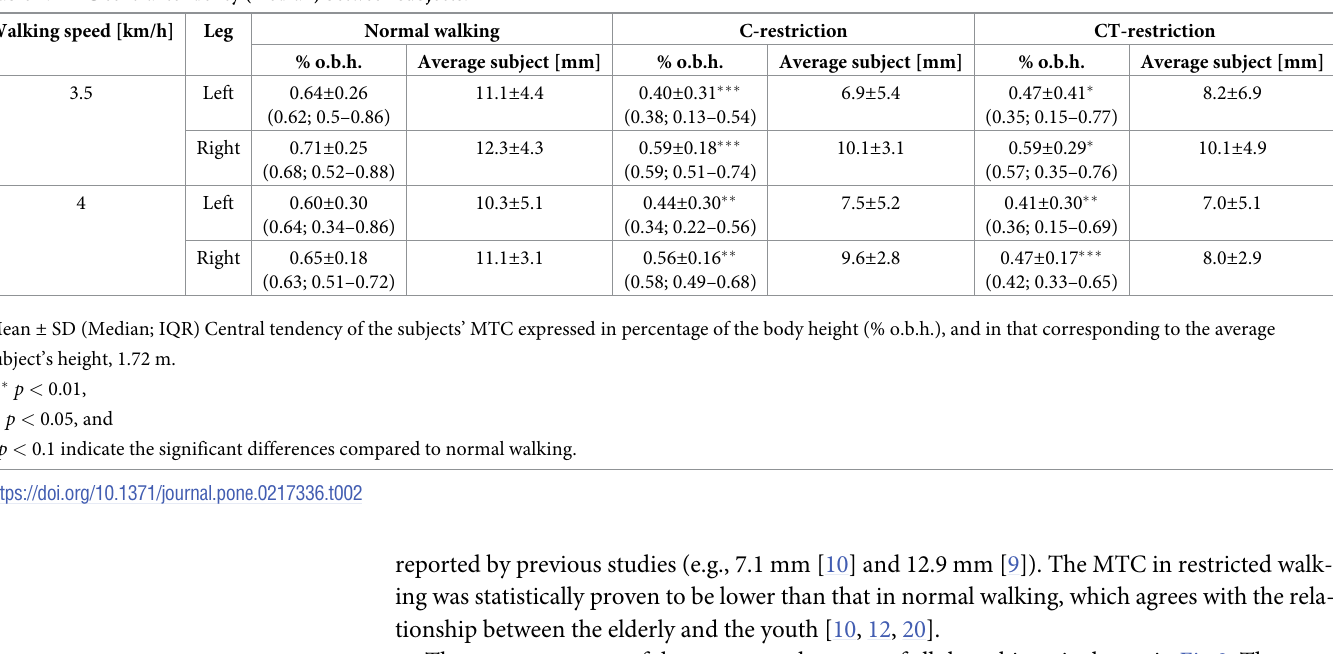
reported by previous studies (e.g., 7.1 mm [10] and 12.9 mm [9]). The MTC in restricted walk- ing was statistically proven to be lower than that in normal walking, which agrees with the rela- tionship between the elderly and the youth [10, 12, 20]. The average pattern of the mean toe clearance of all the subjects is shown in Fig 3. The MTC, which is the lowest point observed in the middle-swing phase, was located between 40- 50% of the swing phase, in agreement with the study of Mills et al. [5]. For each subject, the location of the MTC, during restricted walking, did not differ from that in normal walking. At